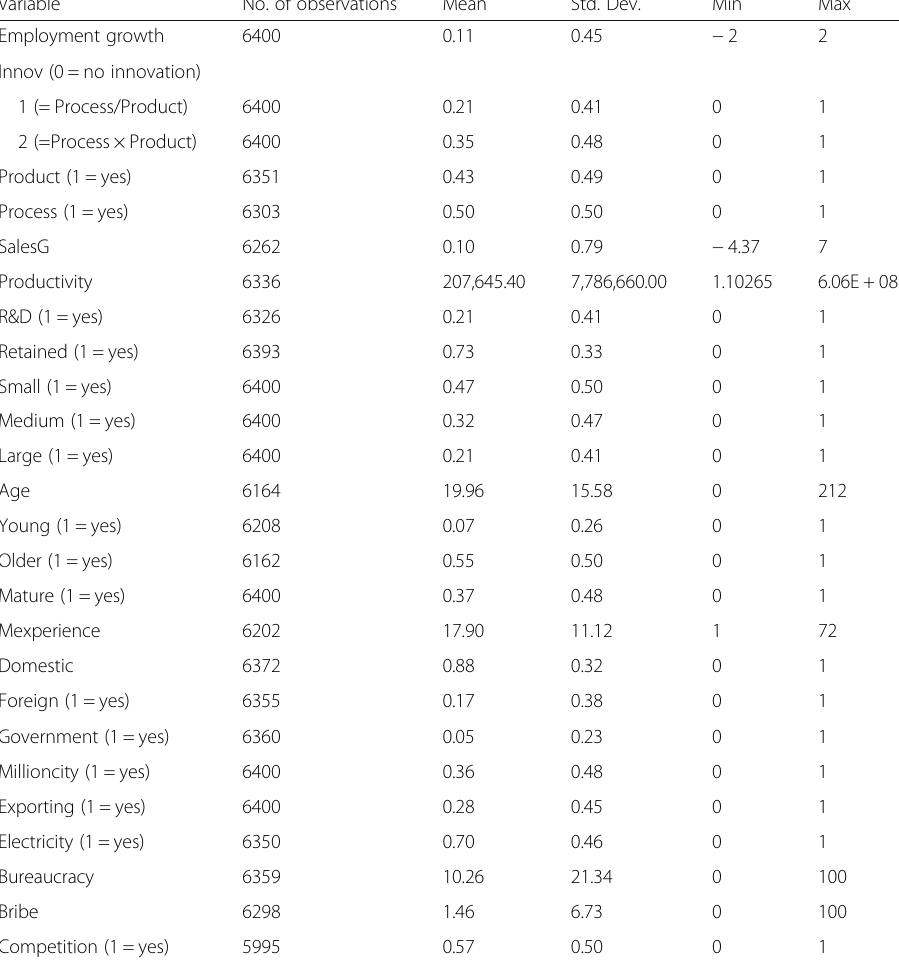
Table 3 Descriptive summary statistics